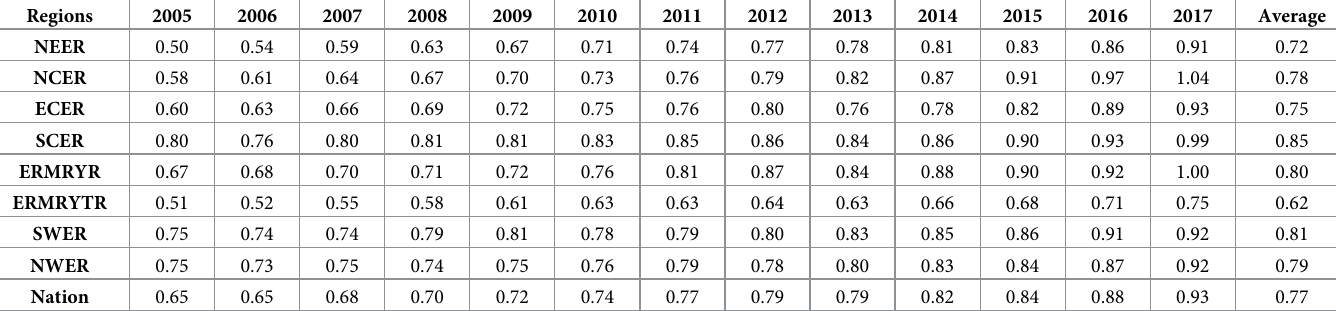
Table 4. The carbon emission performance of China’s eight economic regions in 2005–2017.